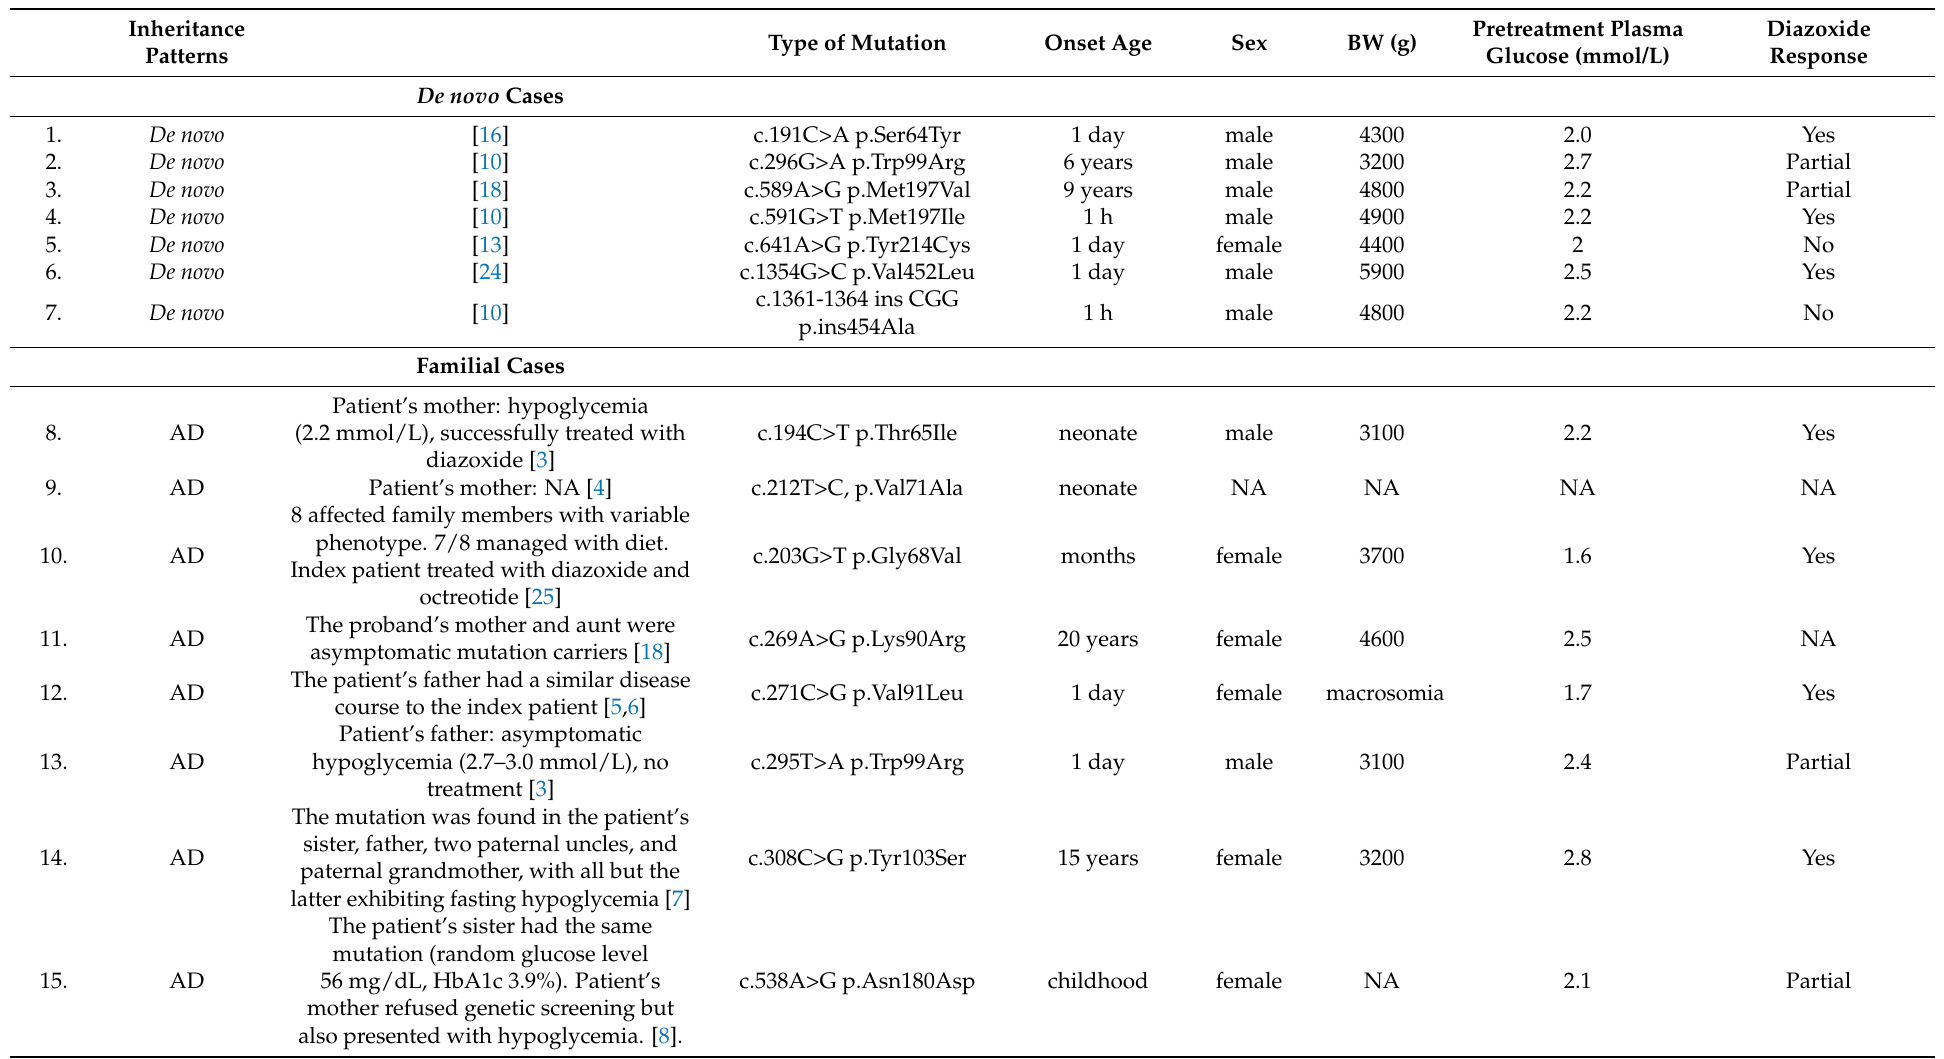
Table 5. Clinical characteristics of reported GCK cases and affected family